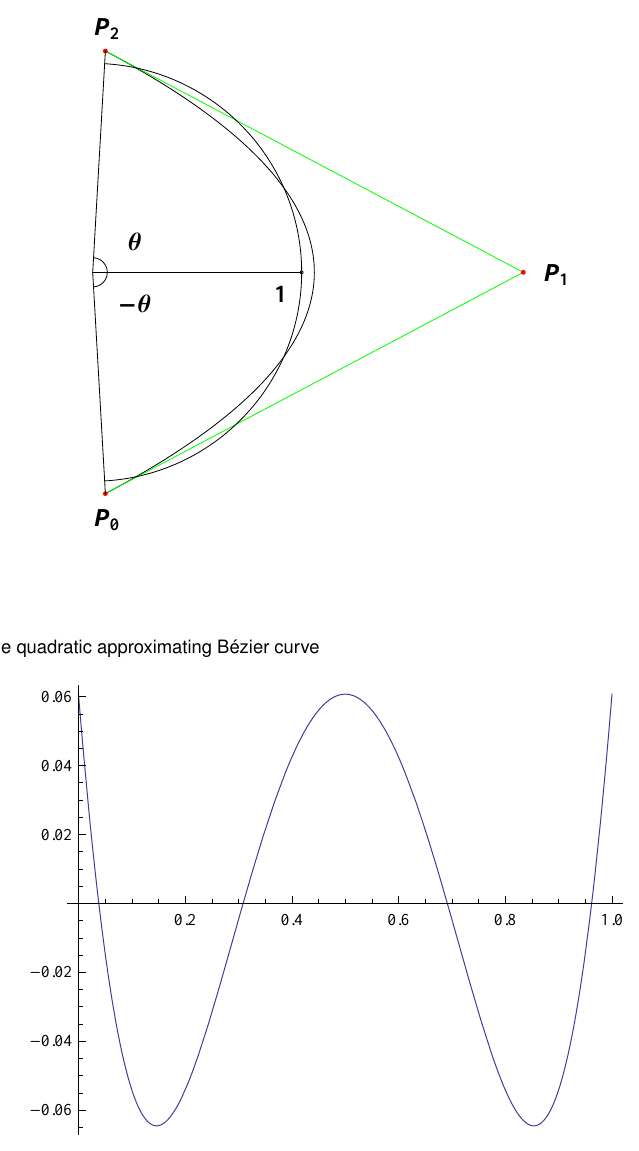
Fig. 3. The circular arc and the quadratic approximating Bézier curve